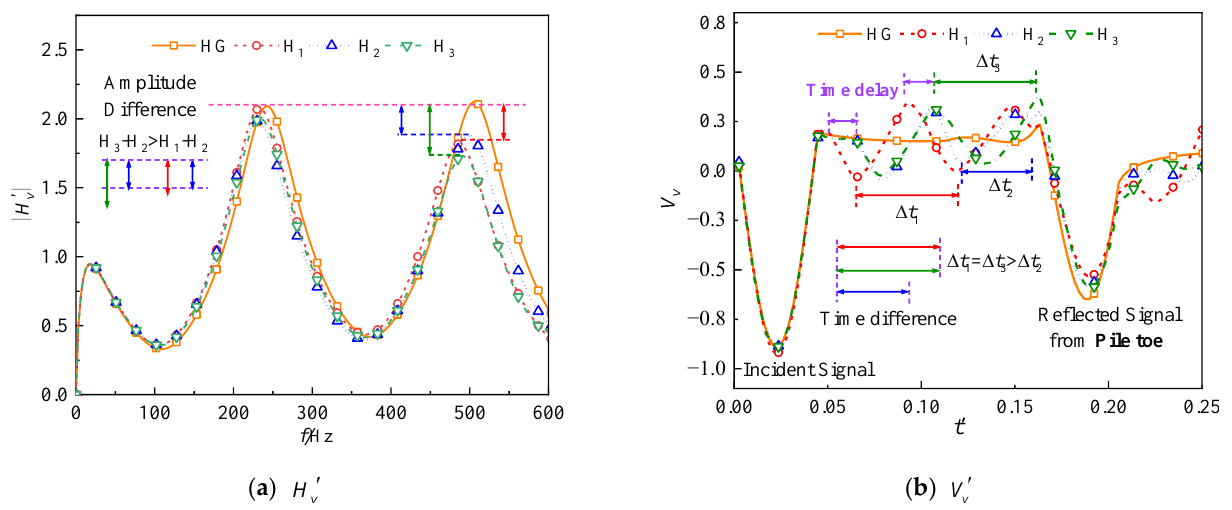
Figure 12. Effect of the depth of necking defects on the pipe pile response. ( a ) H (cid:48) v , ( b ) V (cid:48) v